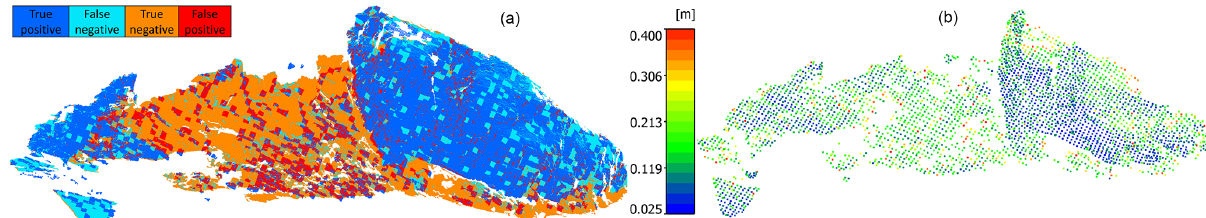
Figure 11. Confusion map of the Burgstall dataset based on the classification with the ICProx (a) and spatial uncertainties for individual octree cells (b) .